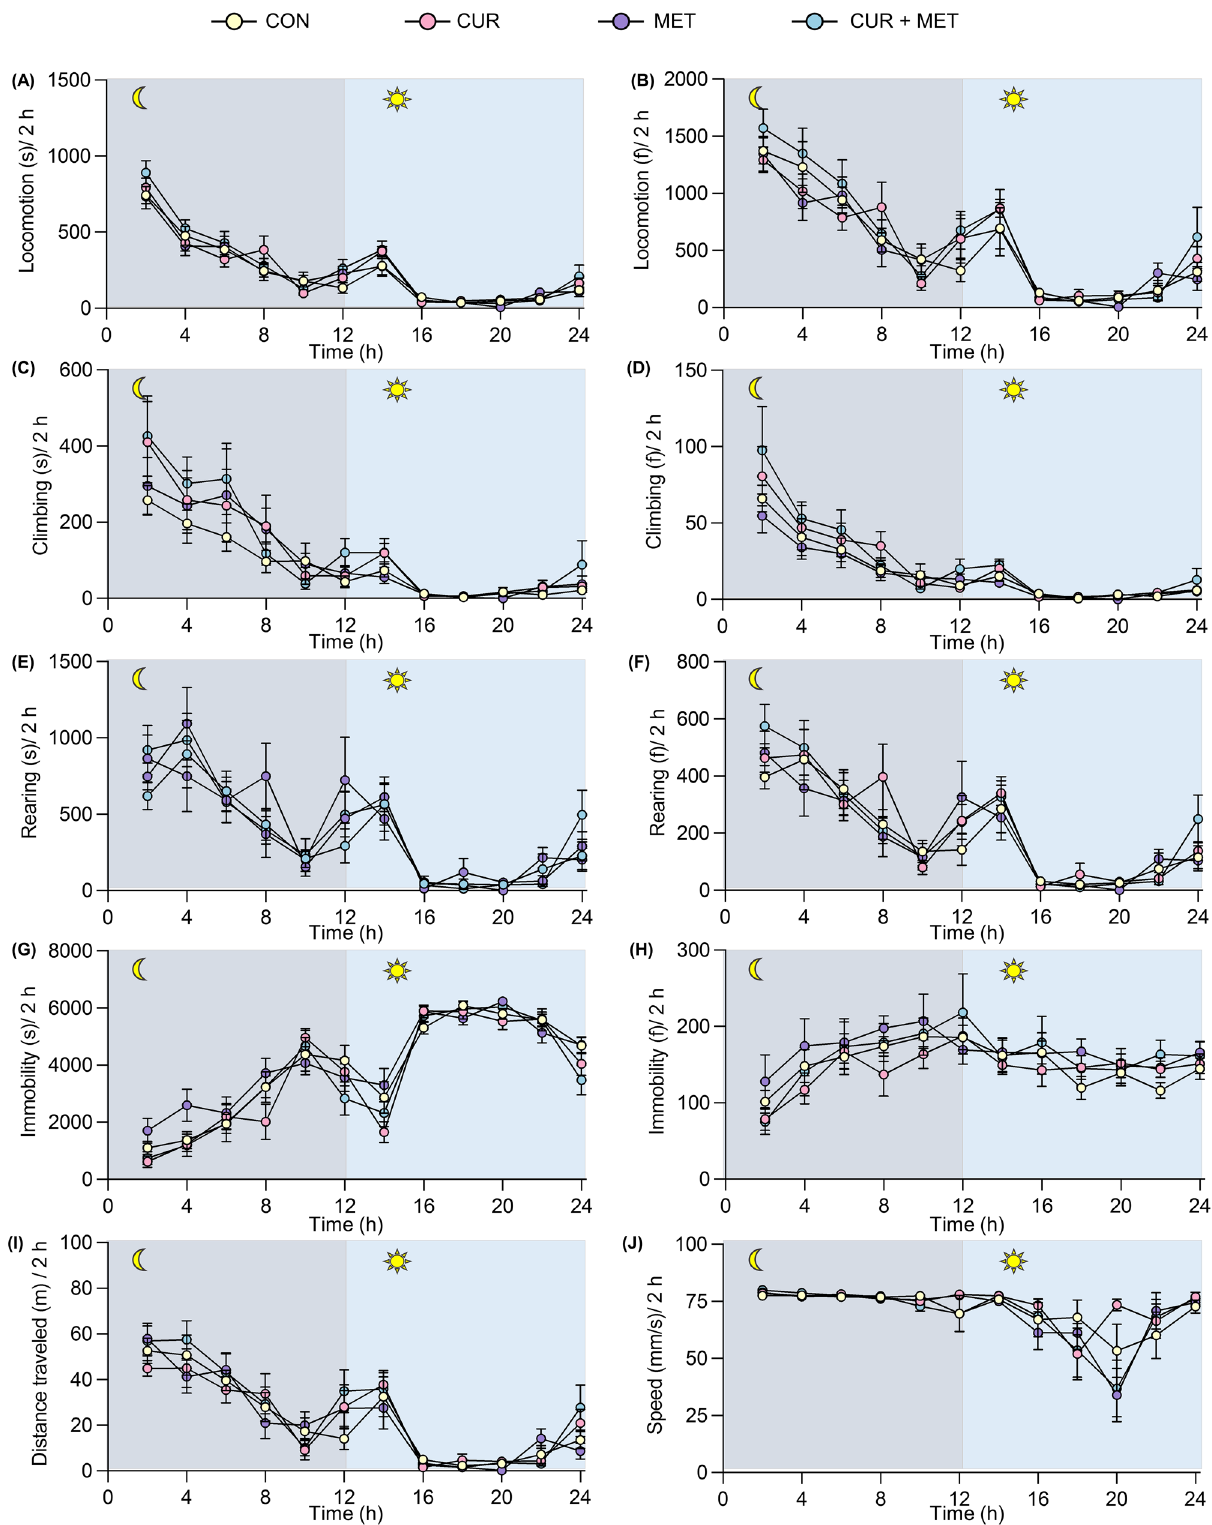
Figure 9. Effects of curcumin and metformin alone or in combination on the general behavior of naïve mice. Behavioral measures were recorded for 24 h post-treatment using LABORAS. ( A,B ) Time spent on locomotion ( A ) and frequency of its occurrence ( B ). ( C,D ) Time spent on climbing ( C ) and frequency of its occurrence ( D ). ( E,F ) Time spend on rearing behavior ( E ) and frequency of its occurrence ( F ). ( G,H ) Time spent on immobility ( G ) and frequency of its occurrence ( H ). ( I ) Distance traveled by mouse in the cage. ( J ) Average speed in locomotion. Data are presented as mean ± S.E.M (n = 10 mice/group). Behavioral data were analyzed over 2 h intervals during 24 h test